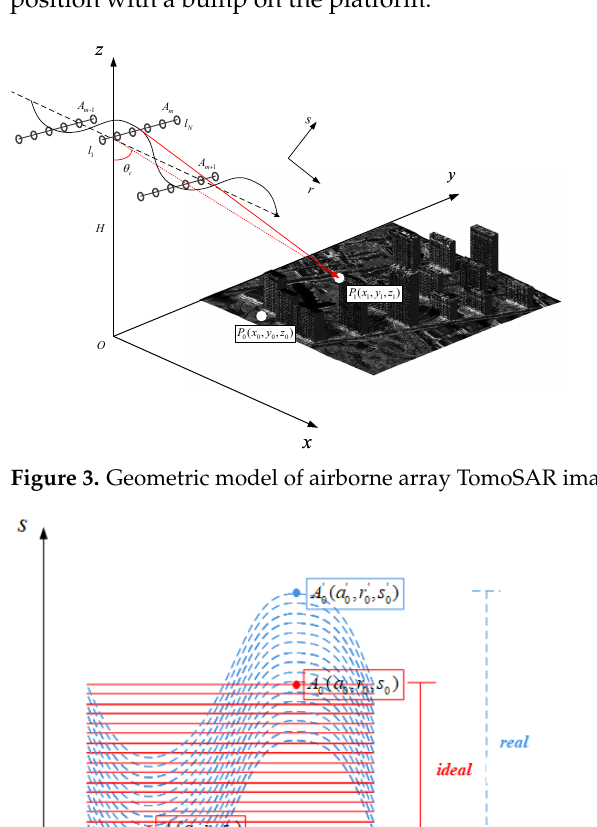
Figure 2. Geometric relationship of the airborne array TomoSAR measurement baseline length. Single-point imaging requires an effective irradiation range within the synthetic aper- ture time. The actual effective baseline length variation projected into the azimuth–elevation geometric plane as shown in Figure 4. The figure clearly shows the antenna array element position with a bump on the platform.